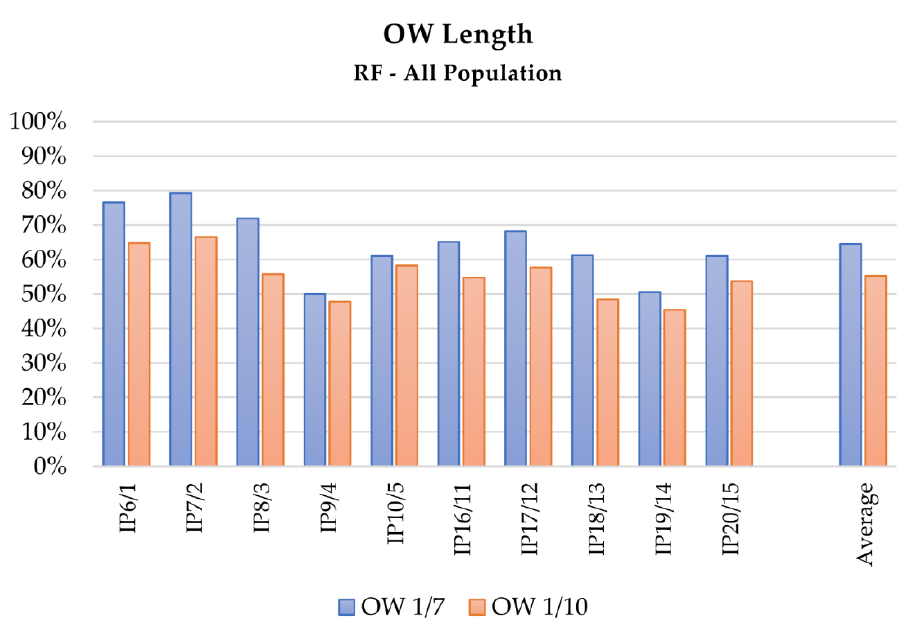
Figure 4. Mean accuracy of the intention prediction for the analysis of complete dataset (healthy and pathological subjects) with the RF algorithm, with respect to the OW length: blue and red the results of the testing with 1/7 and 1/10 of the motion time length, respectively.